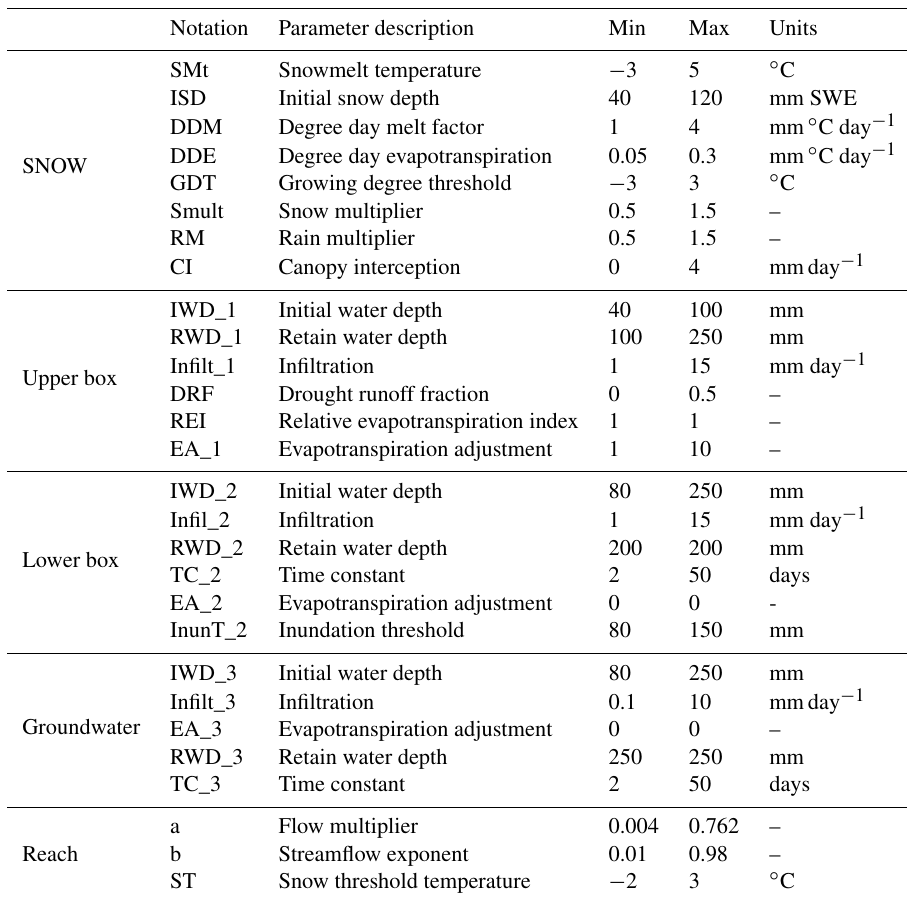
Table 3. Parameter notations, descriptions and ranges used in the Monte Carlo analyses in this